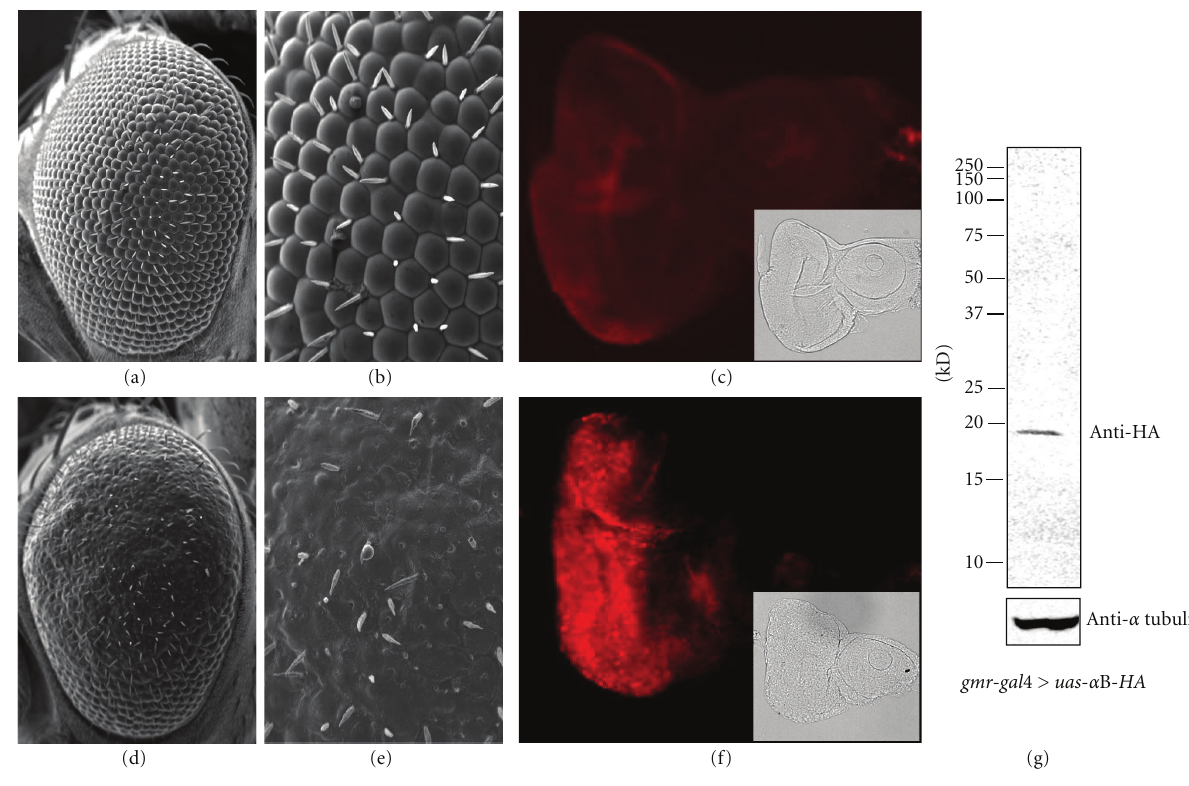
Figure 1: Scanning electron micrographs of adult compound eyes. (a, b) gmr-gal4 ; +; +. (d, e) gmr-gal4; uas- α B-crystallin-HA; +. (c, f) Immunostaining of the eye imaginal discs with anti-HA antibody. The eye disc from gmr-gal4; + ; + flies (c) and gmr-gal4; uas- α B-crystallin- HA; + flies (f). The insets indicate Nomarski images. (g) The anti-HA antibody specifically recognized α B-crystallin-HA in the Western Blot of the eye imaginal discs of gmr-gal4; uas- α B-crystallin-HA ; +